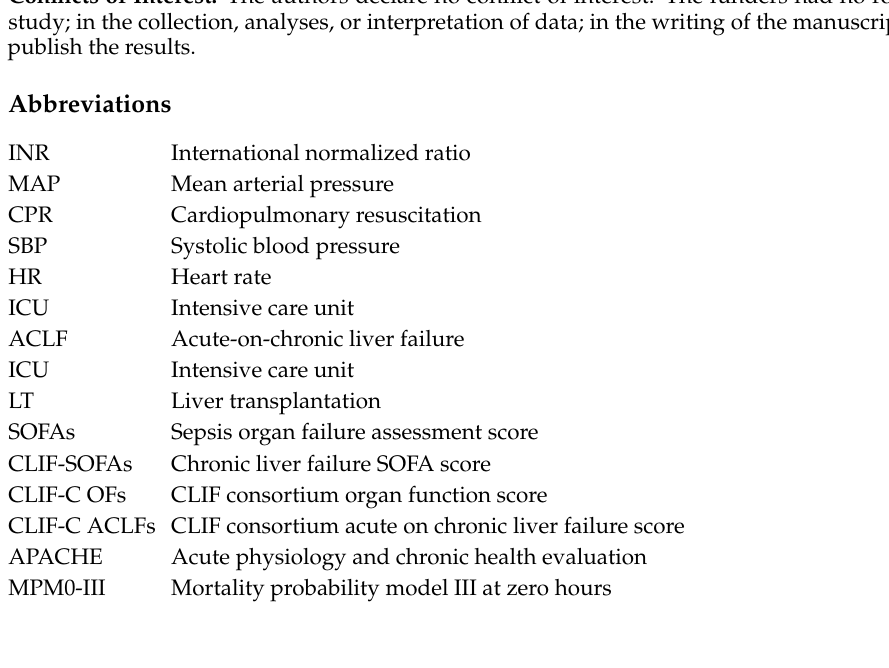
Table S1: The variables that each of the eight scores takes into consideration, Table S2: Demographics of 91